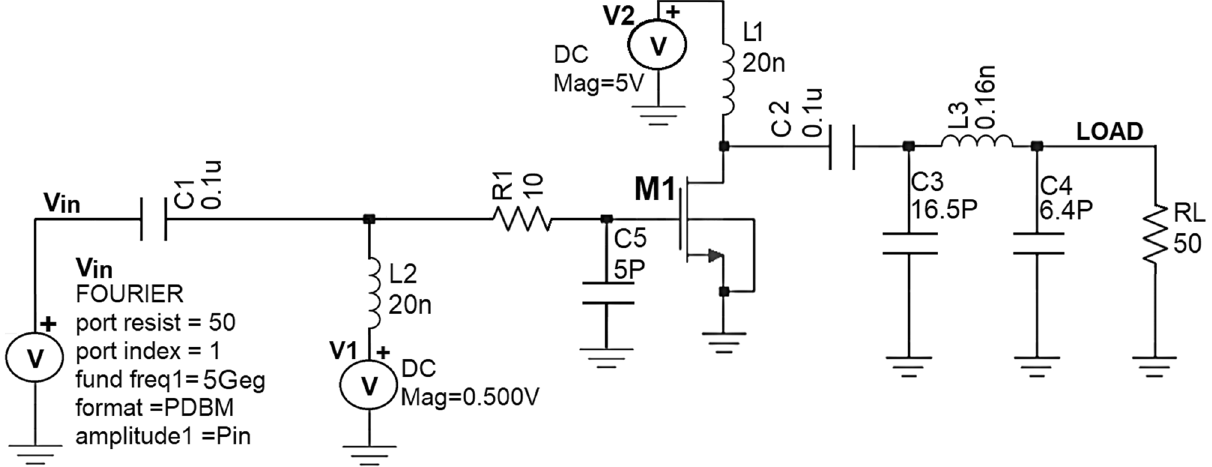
Figure 20. Schematic circuit of the Class-J PA with Fourier input source at 5 GHz.